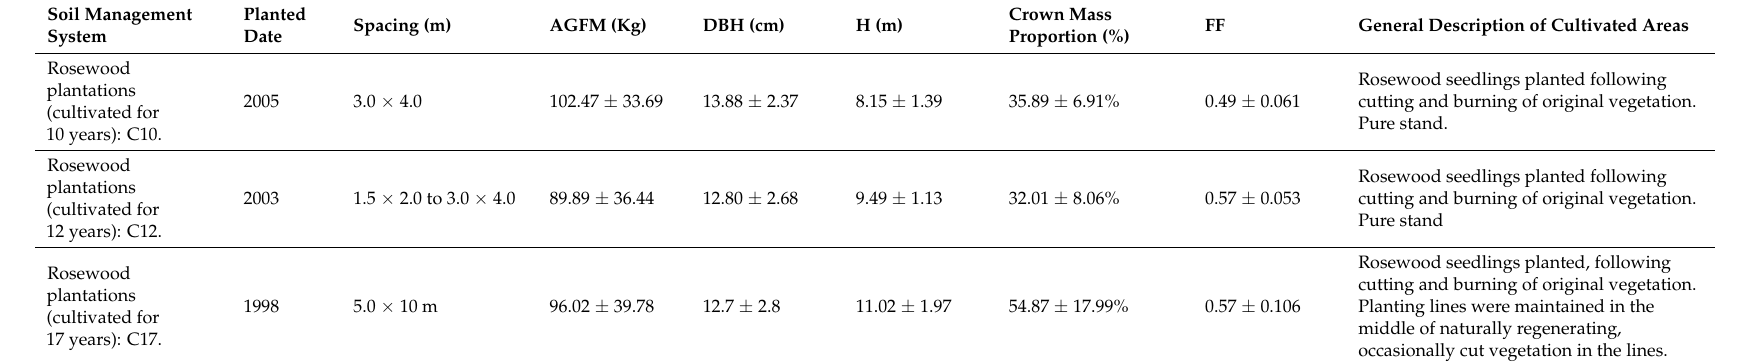
Table A1. Description of study areas showing values for diameter at breast height (DBH) height (H), above-ground fresh mass (AGFM), percentage of canopy fresh weight, and form factor (FF) * of the trees in farmlands near Mau é s and Novo Aripuan ã , Amazonas,